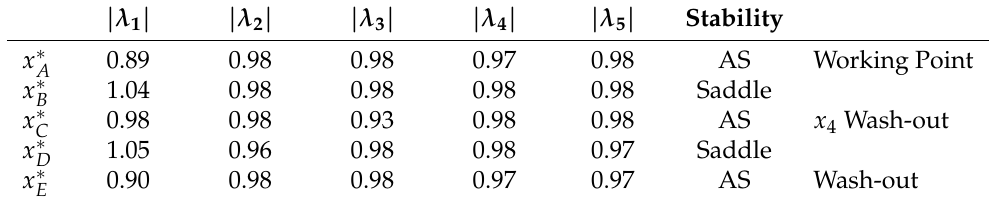
Table 3. Stability of fixed